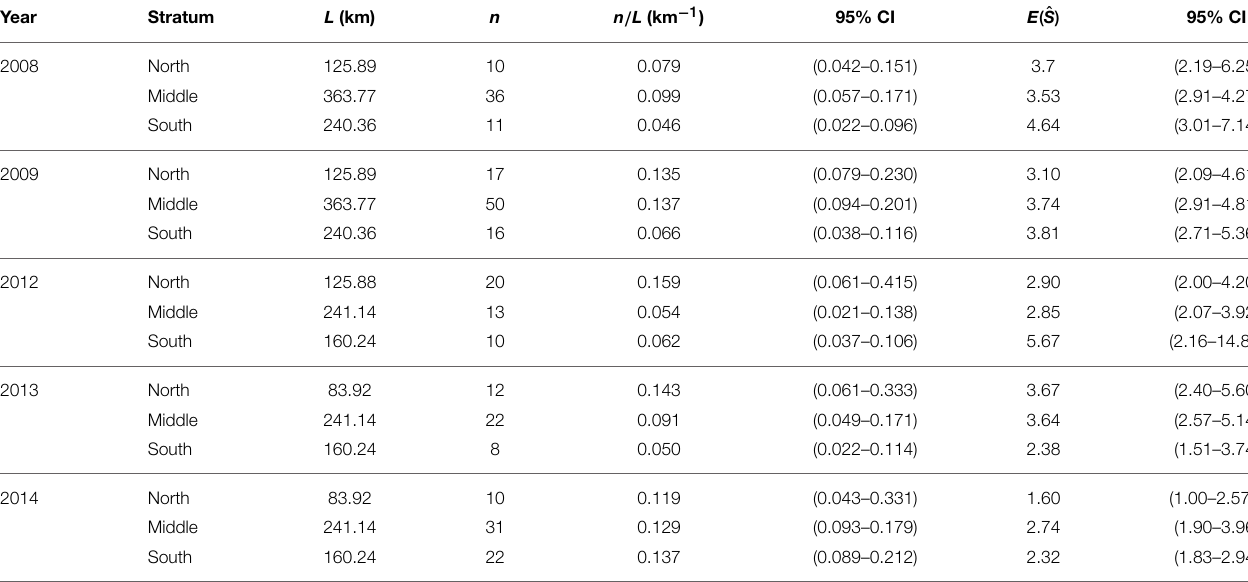
TABLE 2 | Details of the total effort ( L ) per year in each survey